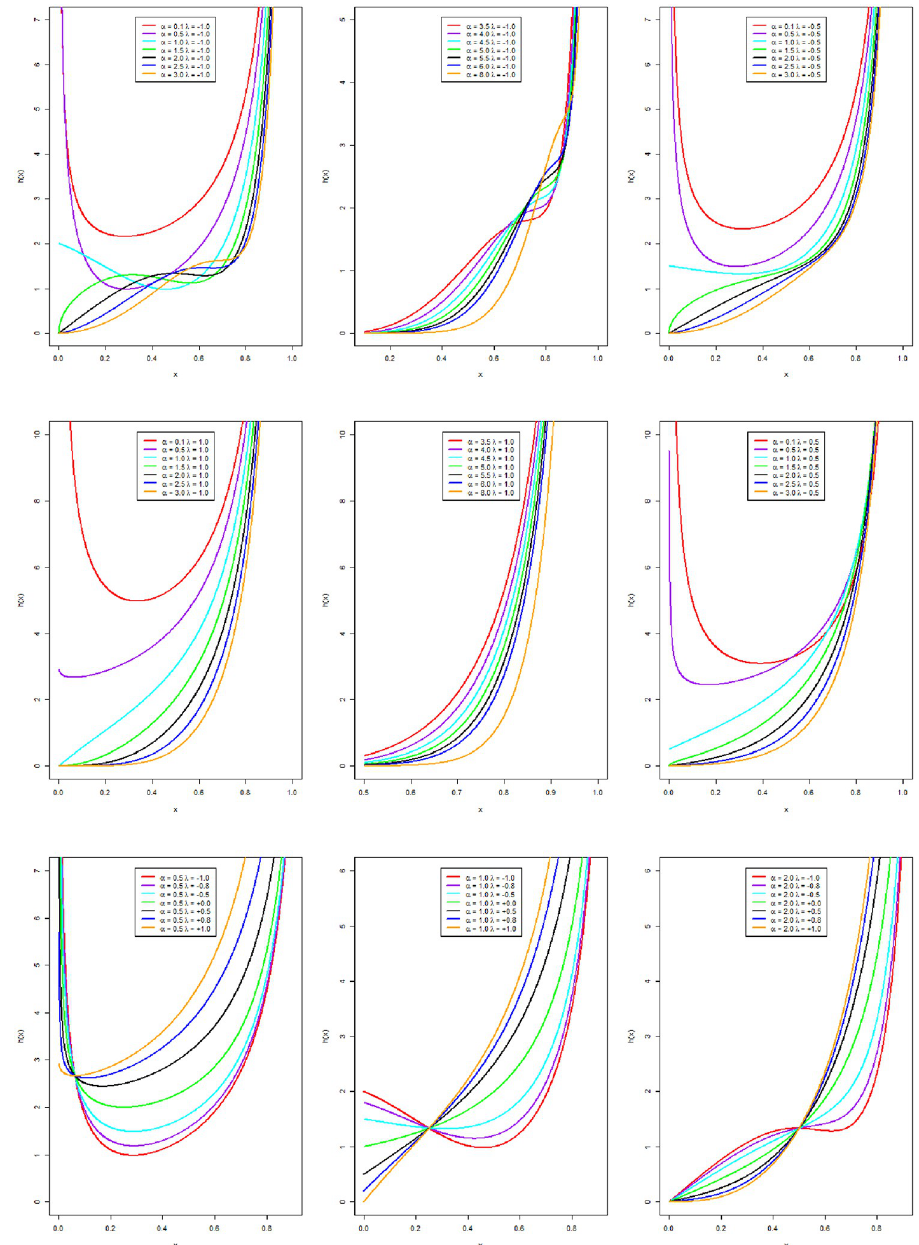
Fig 2. The hrf curves of the NCTPF distribution for different parametric